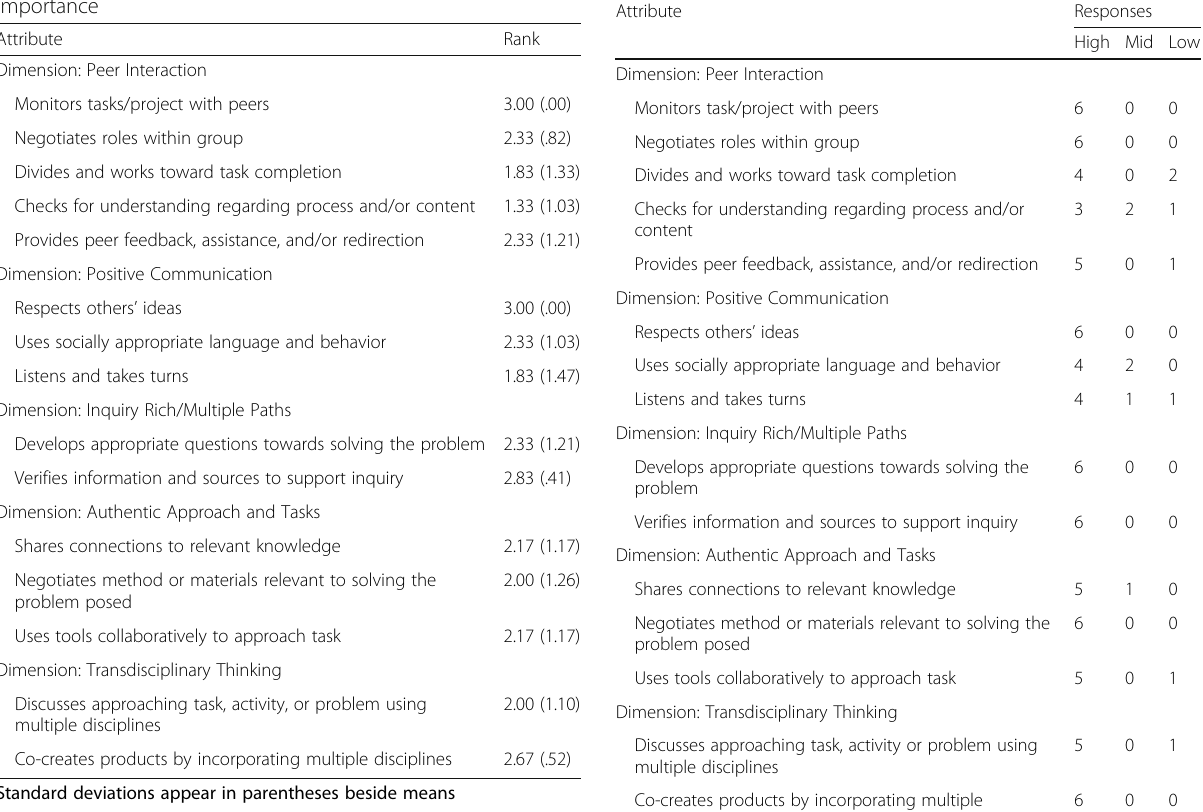
Table 1 Mean scores of attributes based on perceived importance